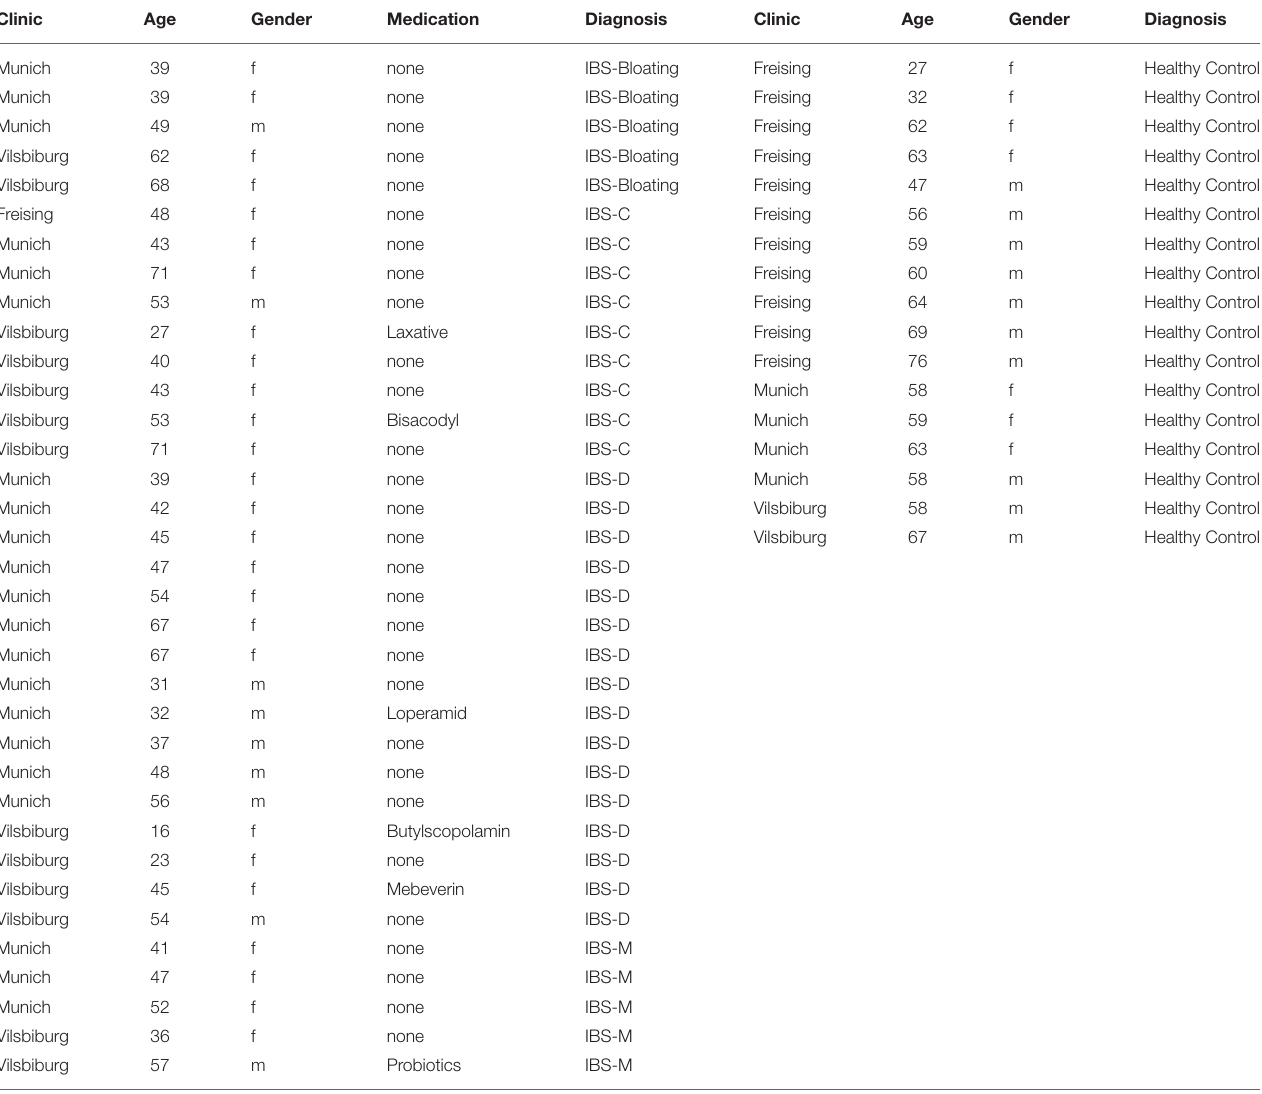
TABLE 1 | Characteristics of IBS patients and healthy